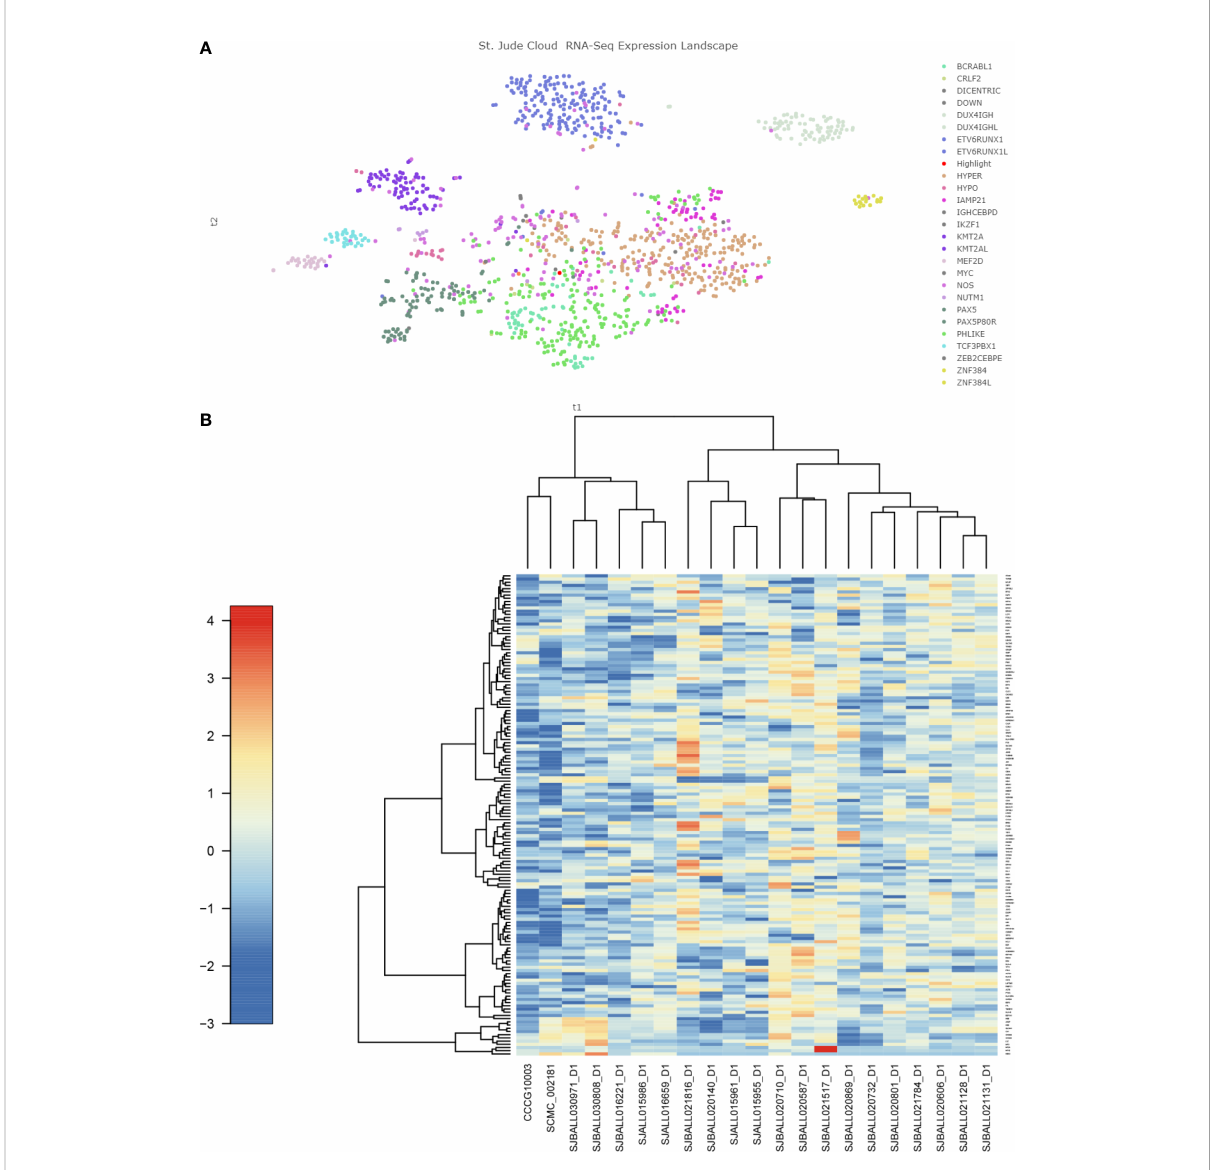
FIGURE 3 Gene expression characteristics of TCF4-ZNF384 (A) The red highlights are the two children with this TCF4-ZNF384, which can be seen not clustered with the other children with ZNF384-fusion. (B) Heatmap of the top 100 genes expressed in TCF4-ZNF384(N=2) and other ZNF384 subtypes (N= 19), as shown in the fi gure, these two patients are also relatively